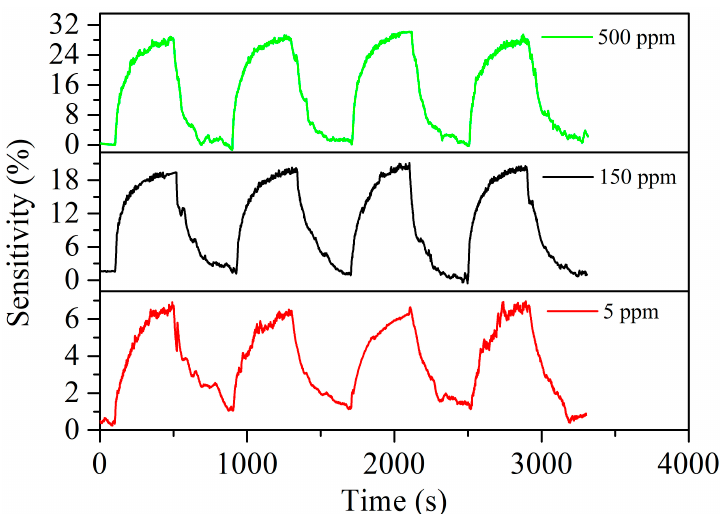
Figure 7. Repeatability of the Ag–SnO 2 /rGO nanocomposite film sensor toward acetylene concentrations of 5, 150 and 500 ppm at 90 °C.